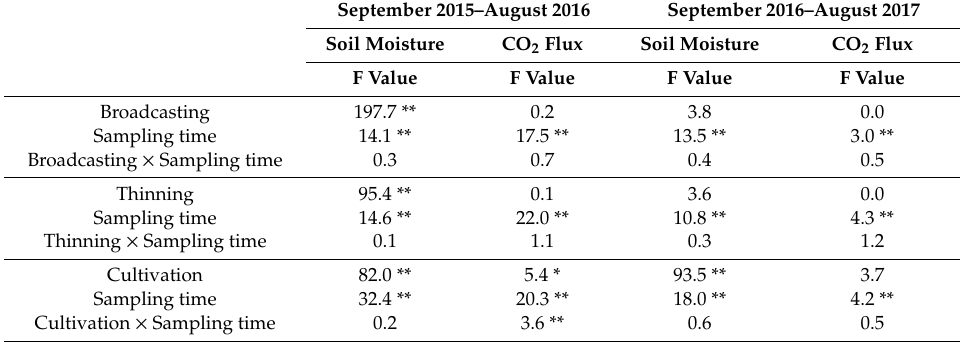
Table 2. Summary of two-way repeated-measures analysis of variance for the e ff ect of broadcasting, thinning, cultivation, and sampling time on the soil moisture content and CO 2 flux.